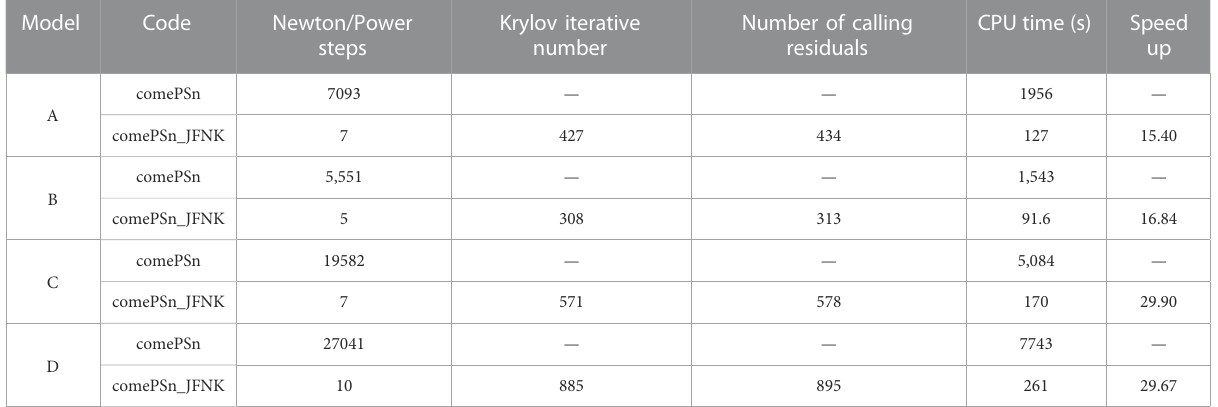
TABLE 5 Comparison of the computational cost for 2-D Full-core MOX/UOX pin-by-pin models A – D. Model Code Newton/Power